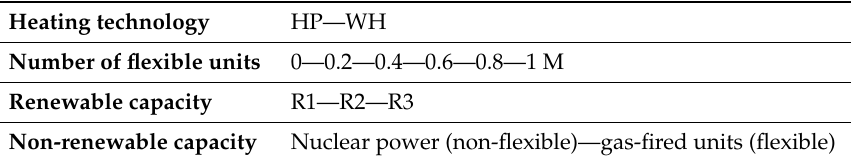
Table 1. Parametric analysis